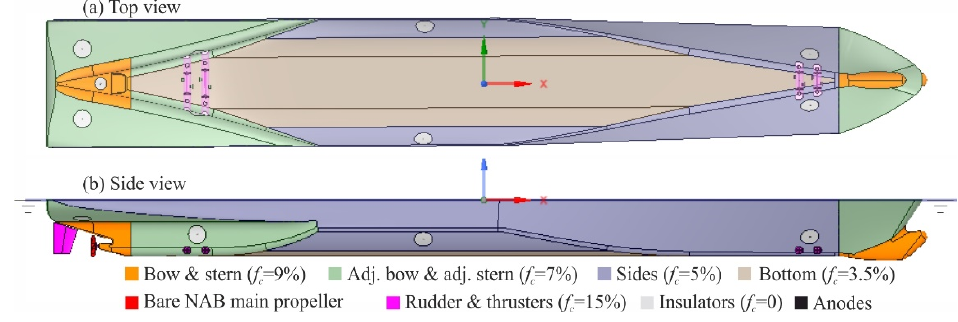
Figure 3. Coating damage to various regions of the ship.